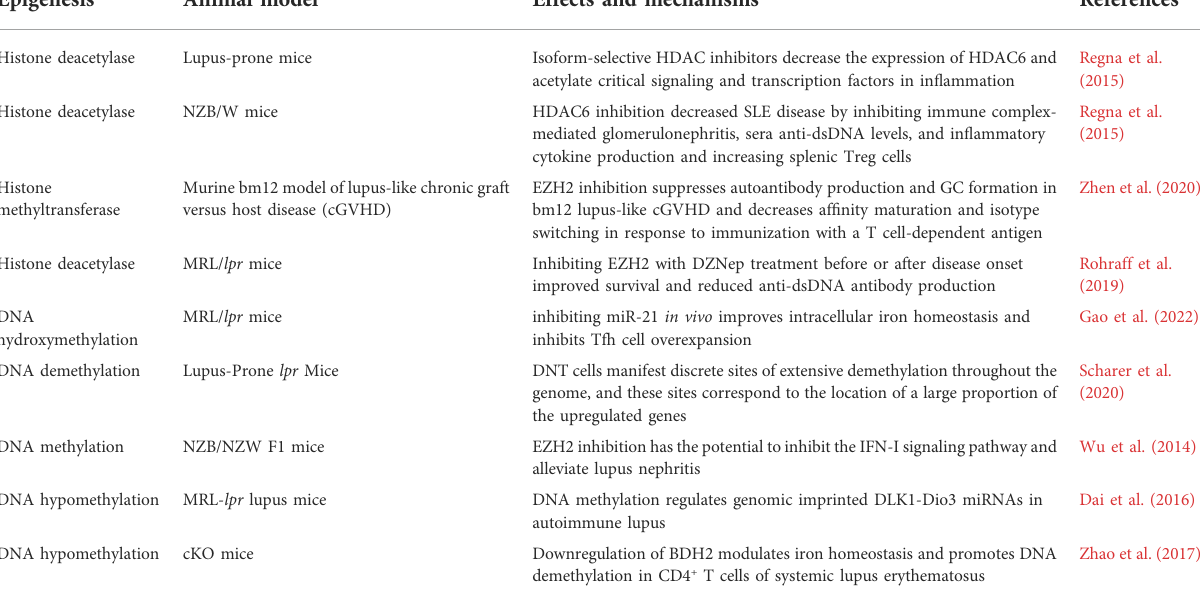
TABLE 2 Epigenetics on LN in animal